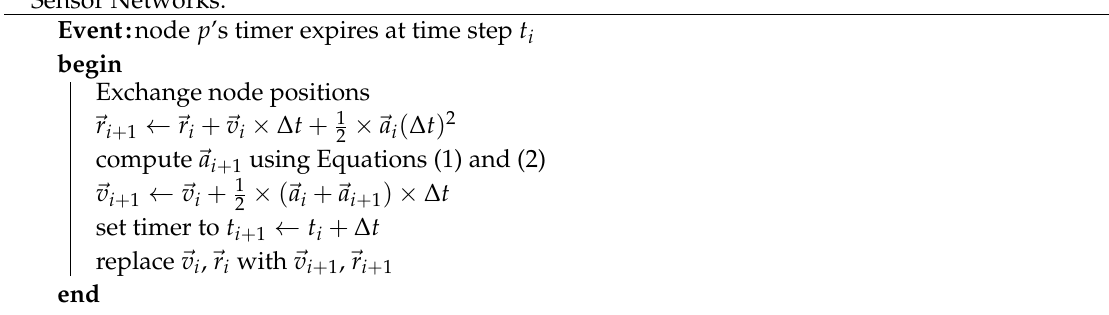
Algorithm 1: Distributed Algorithm for Leapfrog in Virtual Spring Force (VFA-SF) in Wireless Sensor